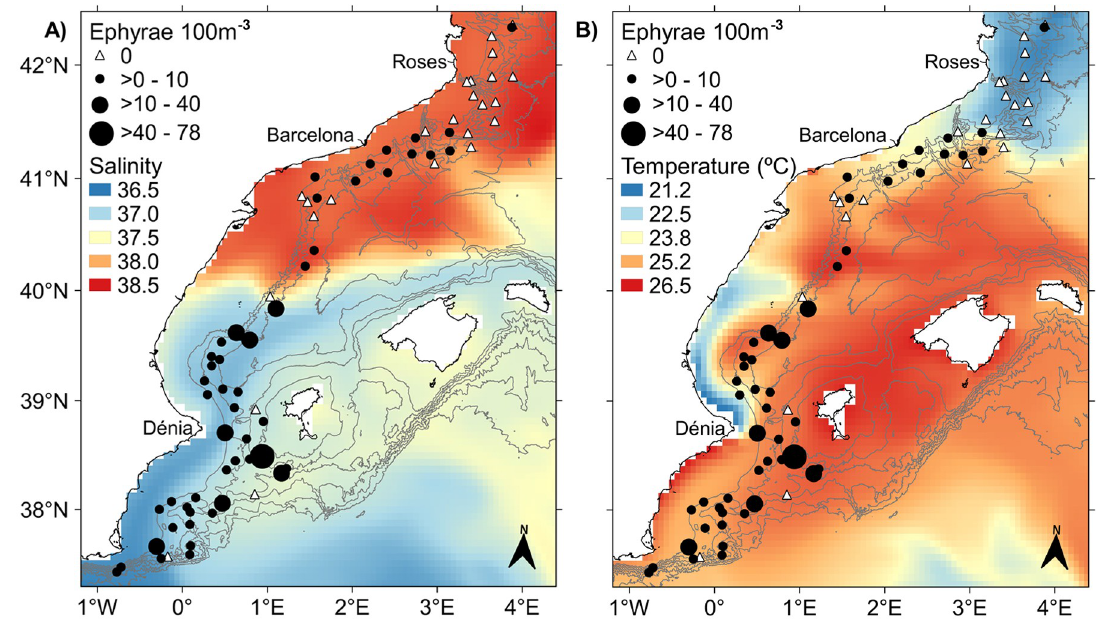
Fig 7. Horizontal distribution of P . noctiluca ephyrae overlaid on the mean a) salinity and b) temperature at 10 m depth for the sampling period from CMEMS reanalysis [45]. Coastline is from Instituto Hidrogra´fico de la Marina [52] and isobaths (every 400 m) are from EMODnet